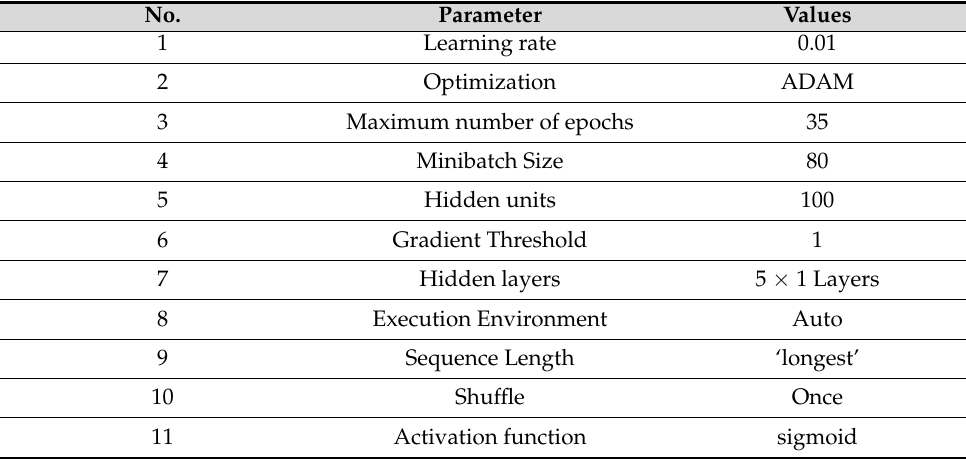
Table 3. The hyperparameters’ values for